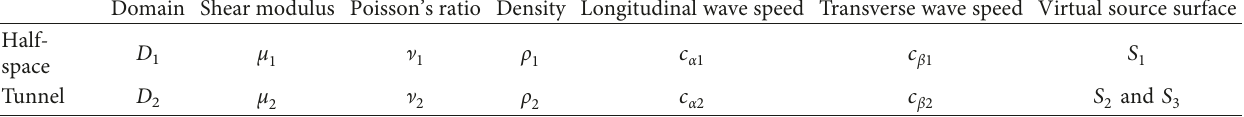
Table 1: Half-space and tunnel